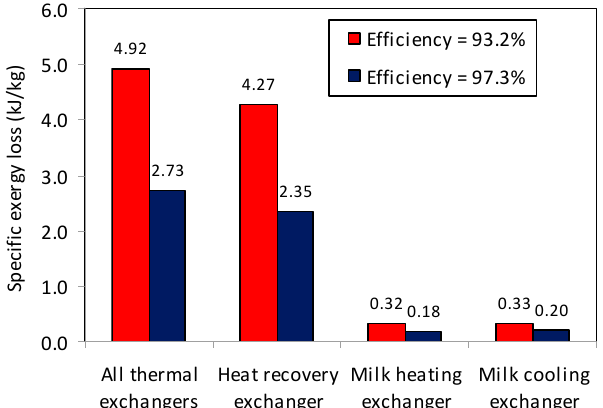
Figure 3. Comparison between exergetic losses in all thermal exchangers system and in each exchanger with the optimized efficiency ε opt = 97.3% and with the current efficiency ε A = 93.2%.